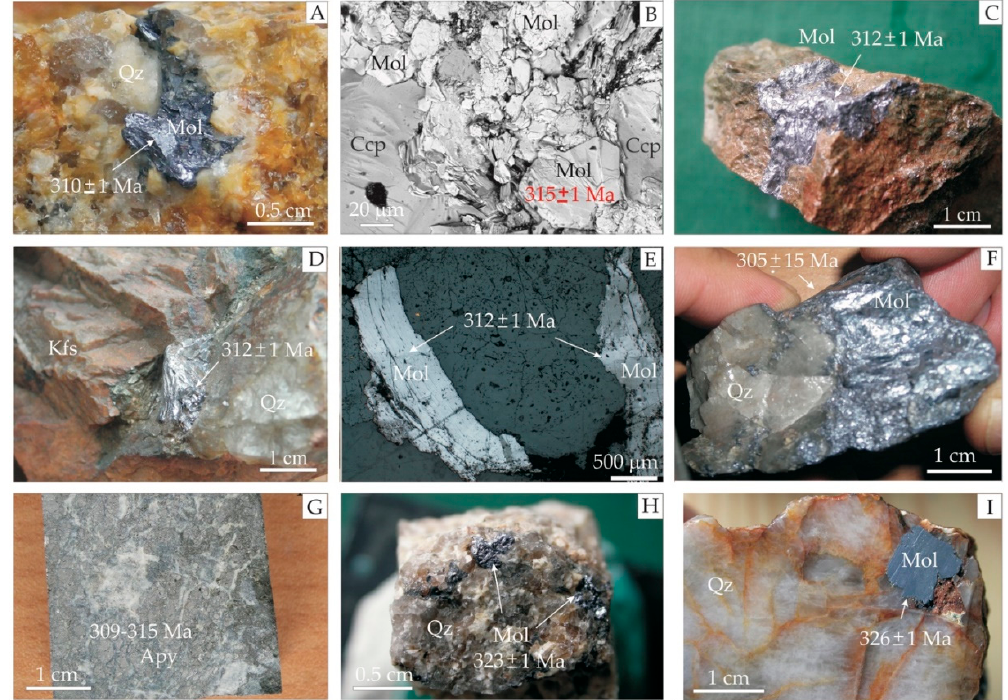
Figure 14. ( A – I ) Photographs of molybdenites and arsenopyrite from the Karkonosze Pluton and its eastern metamorphic cover with its Re-Os isotopic ages after [5,6,87]. ( A ) Molybdenite (Mol) plates disseminated in pegmatitic intergrowths of quartz (Qz) and K-feldspar, Szklarska Por ę ba Huta granite quarry; ( B ) hexahedral molybdenite (Mol) plates in association with chalcopyrite (Ccp), abandoned Micha ł owice quarry. BSEI; ( C ) molybdenite (Mol) coat-like aggregate in skarn, abandoned Kowary Fe-U mine; ( D ) molybdenite (Mol) crystal aggregate hosted by quartz-K-feldspar rock, Kowary Fe-U mine; ( E ) fragment of sample from ( D ) macrophotography with molybdenite (Mol) as separate bladed crystals under reflected light; ( F ) molybdenite (Mol) crusty aggregates in quartz (Qz) vein, Miedzianka Cu-(U) deposit; ( G ) massive Co-bearing arsenopyrite in (Apy) quartz vein, Czarnów As-polymetallic deposit; ( H ) fine molybdenite (Mol) crystals intergrown with vein quartz (Qz), Szklarska Por ę ba Huta granite quarry; ( I ) molybdenite (Mol) in fractured quartz (Qz) vein with rusty Fe ochre along fractures, Ł omnica Górna abandoned granite quarry.